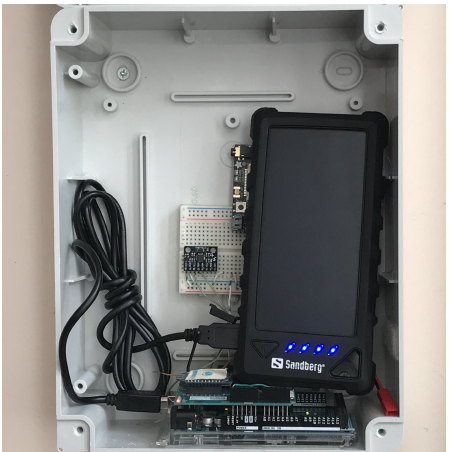
Figure 1. A node of the developed system enclosed in its protective case, along with its battery.